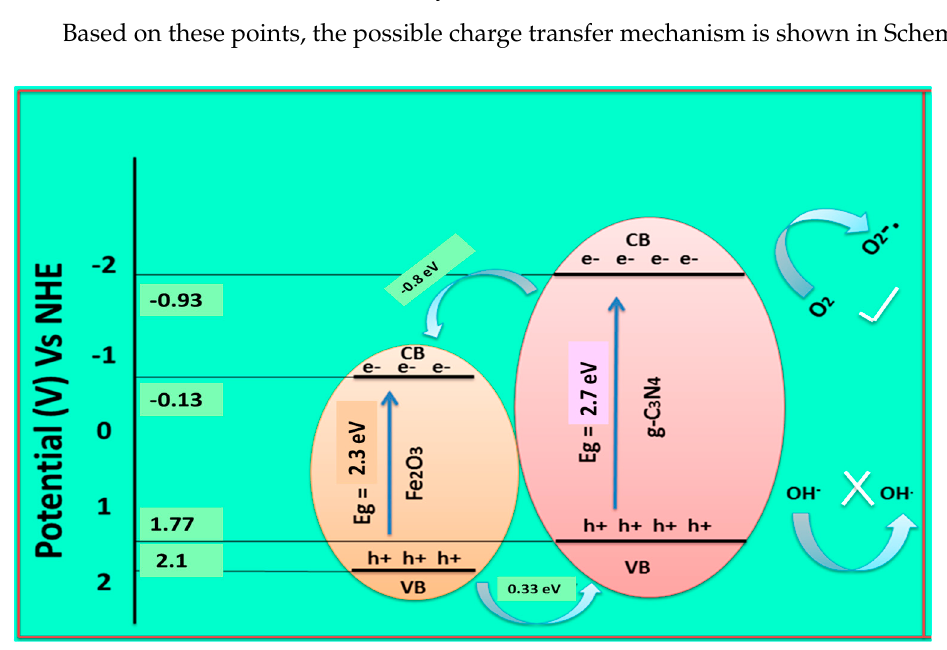
Scheme 1. Band structure and possible charge transport mechanism.